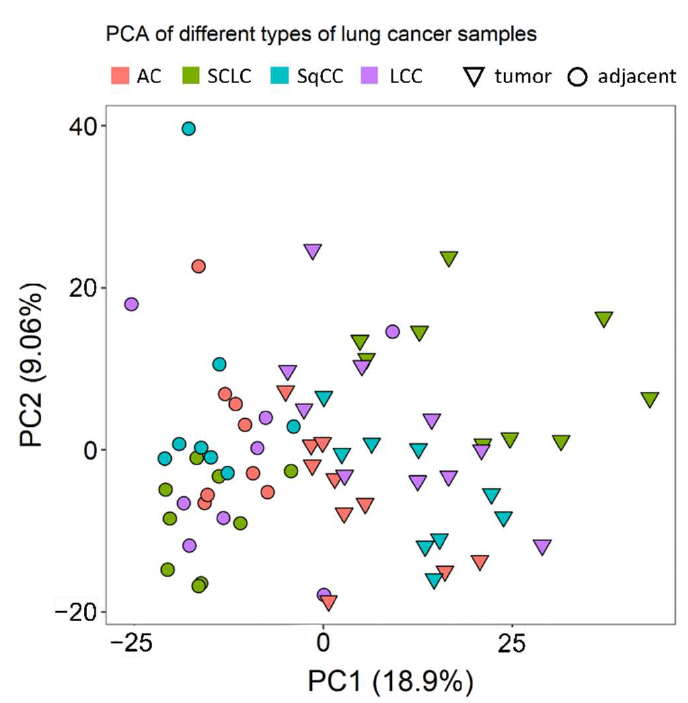
Figure 1. PCA of the different samples analyzed. Triangles and circles indicate tumor and tumor- adjacent samples, respectively. Different colors mark different LC types (red for AC, green for SCLC, turquoise for SqCC, and purple for